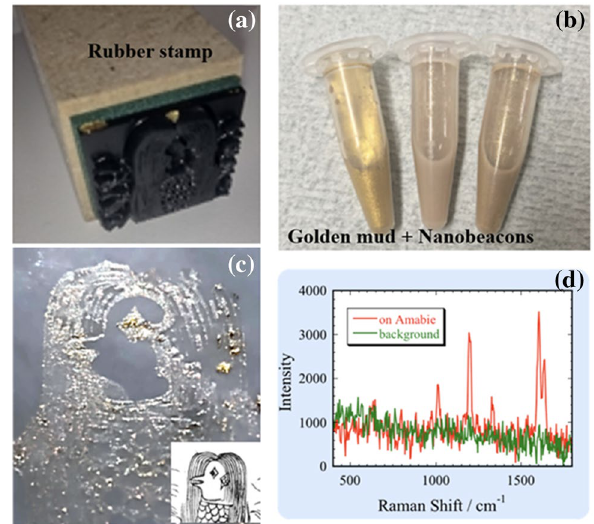
Figure 6. Example of hidden embedded information: ( a ) Rubber stamp with Amabie engraved. ( b ) Stamp ink comprising Au mud paint and nanobeacons. ( c ) Stamped Amabie. Inset: original figure. ( d ) Raman spectra of Amabie and background. We processed the Amabie portrait from a photograph courtesy of the Main Library of Kyoto